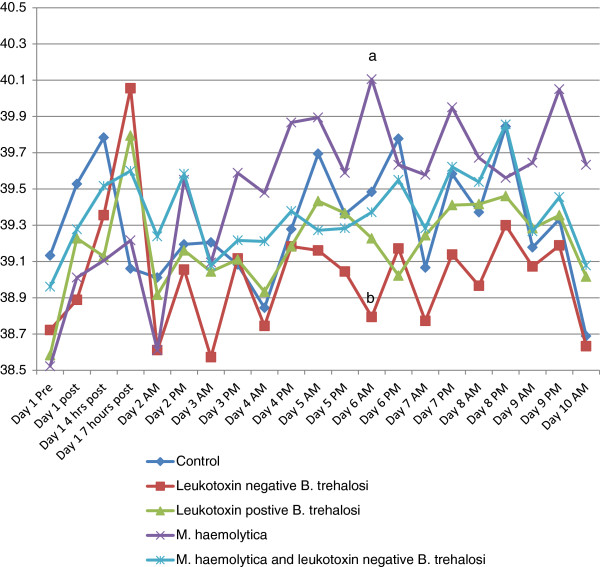
Temperature over time by treatment group. Line graph of rectal temperature by treatment group for each time point when temperature was recorded. Time points that were statistically different are indicated by different letters (a or b).